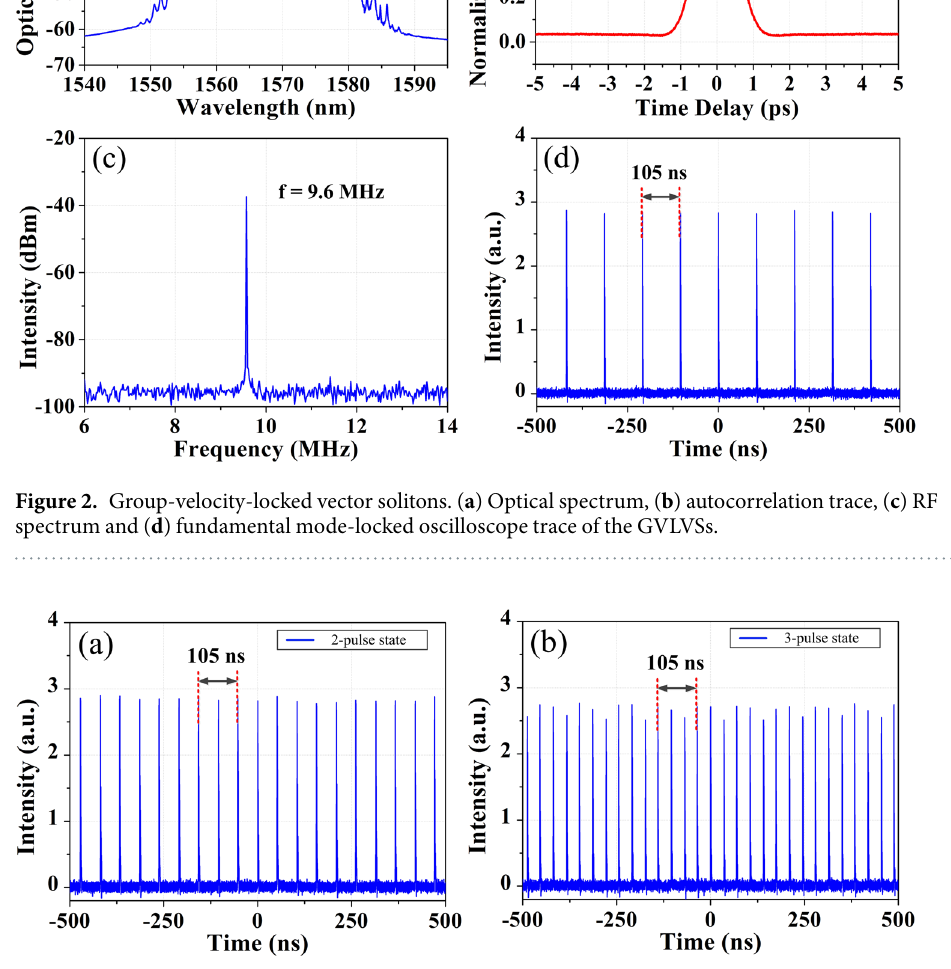
Figure 3. Oscilloscope traces of multi-pulse states. ( a ) Dual-pulse and ( b ) Triple-pulse